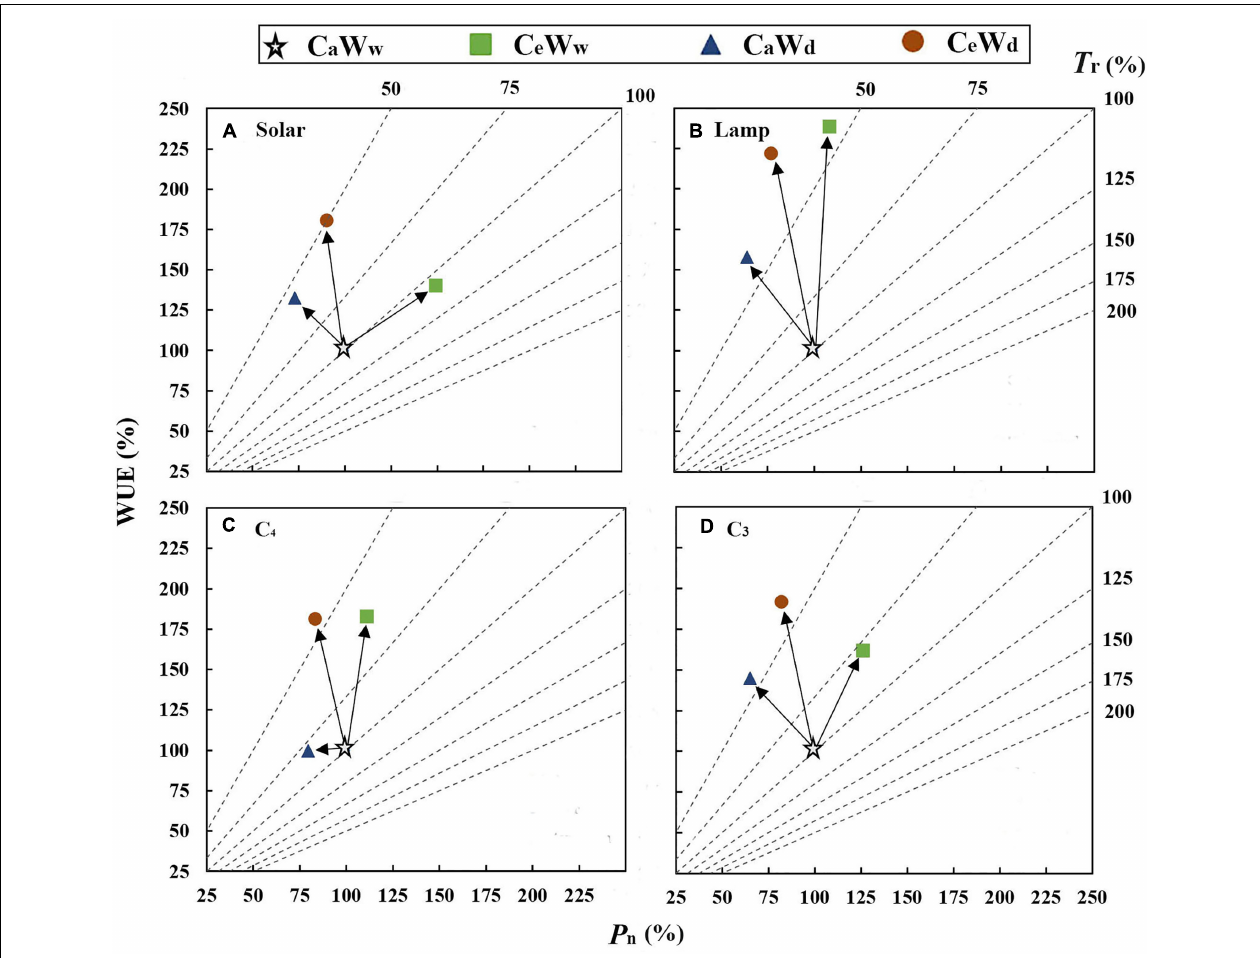
FIGURE 6 | Graphical vector analysis showing the effects of e[CO 2 ] and water deficit on P n , T r , and WUE (C e W d , orange circle; C e W w , green box; C a W d , blue triangle; and C a W w , white star). (A) Plants grown under solar radiation; (B) plants grown under lamps; (C) C 4 plants; and (D) C 3